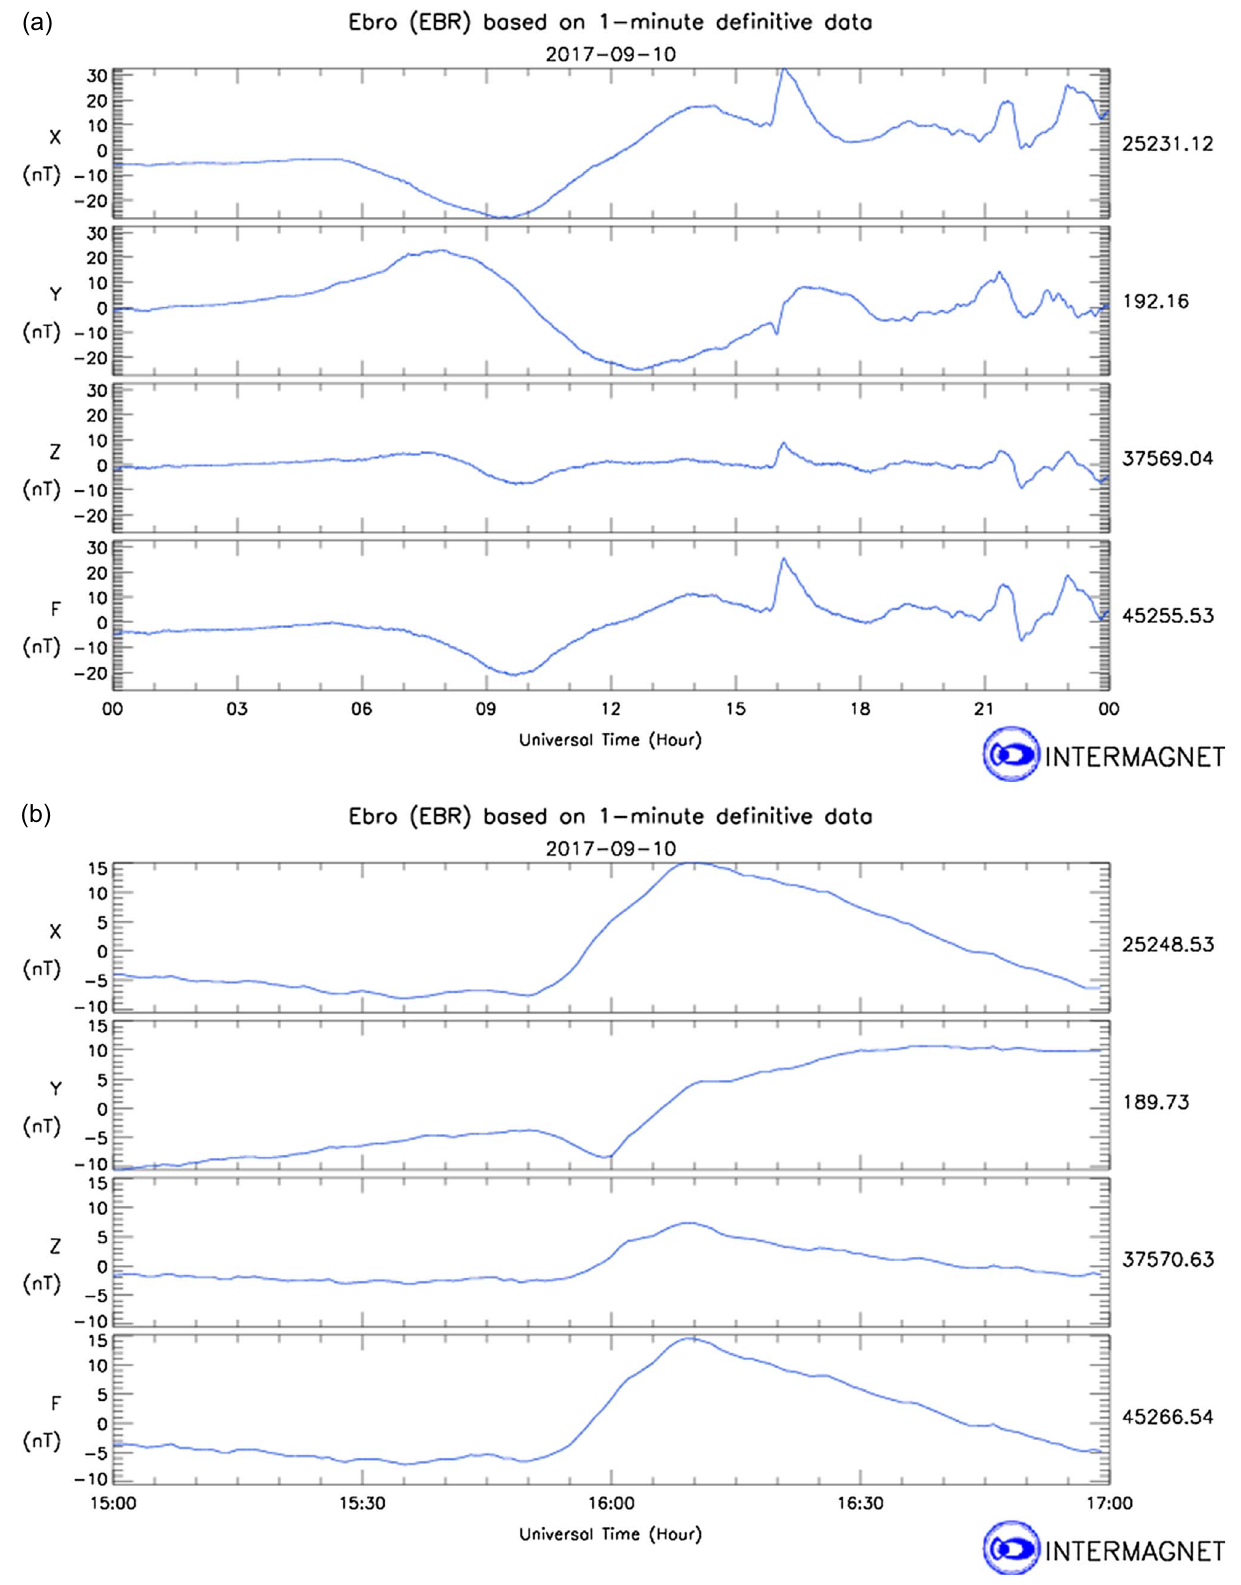
Fig. 16. (a) Ebro magnetogram corresponding to September 10, 2017, with Sfe at 15:51. (b) Detail of this magnetogram magnifying the time of this long-lasting